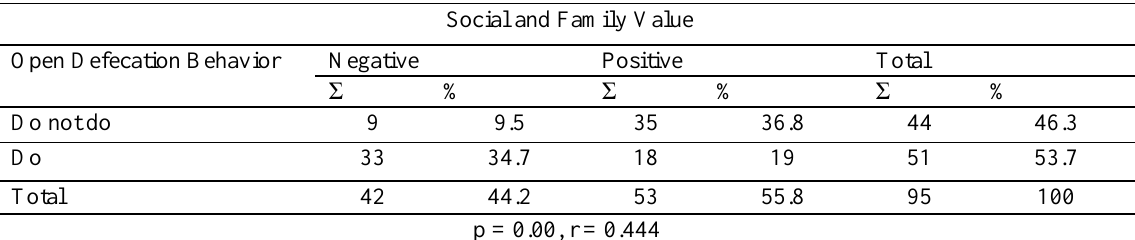
Table 4. The relationship between social and family value with open defecation behavior in school age children Social and Family Value Open Defecation Behavior